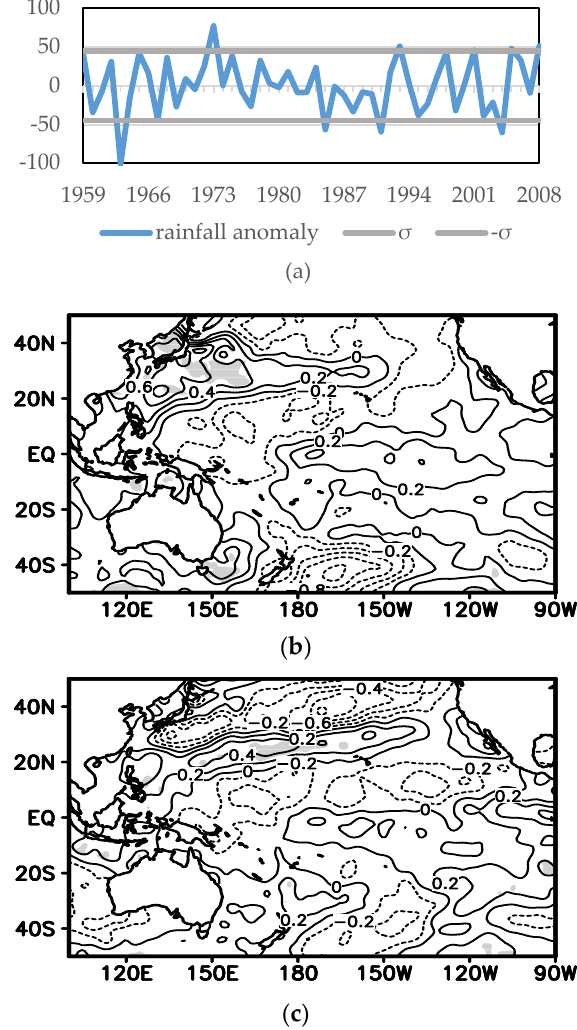
Figure 4. The rainfall anomaly ( a , unit: mm·mo −1 ), the Pacific SST differences between high precipitation years and low precipitation years in PFSSC, January-March ( b ), April–June ( c ) (shaded area represent 0.1 reliability from t-test, unit: °C).